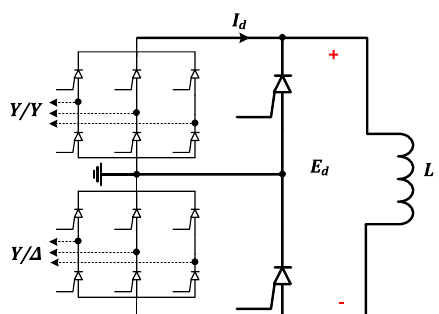
Fig. 6 The schematic diagram of the SMES unit